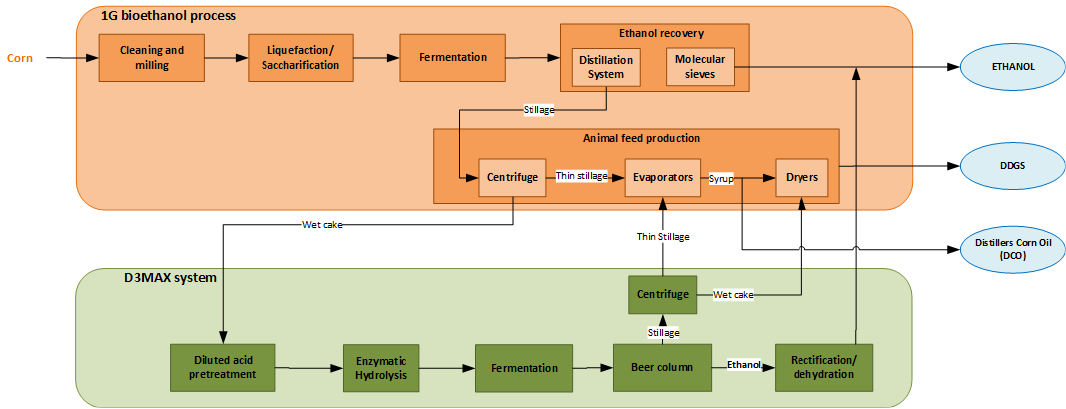
Figure 9. Schematic diagram of D3MAX technology (adapted from [143]).